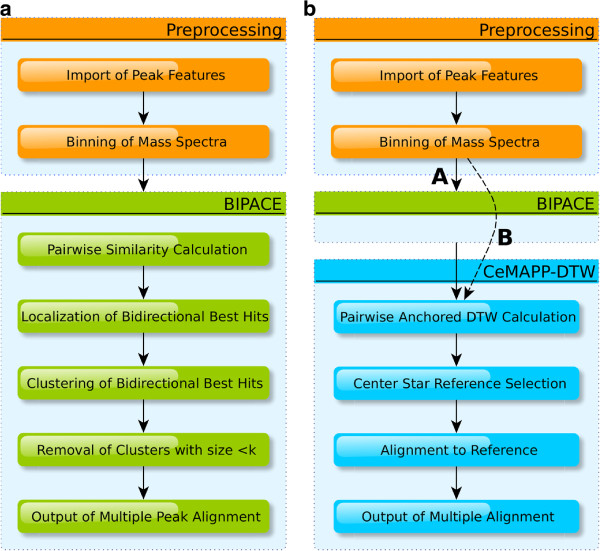
Workflow for evaluation of BIPACE and CeMAPP-DTW. (a) Sequence of preprocessing commands for evaluation of BIPACE. (b) Sequence of preprocessing commands for evaluation of CeMAPP-DTW. Path indicated with (A) with and (B) without anchors.